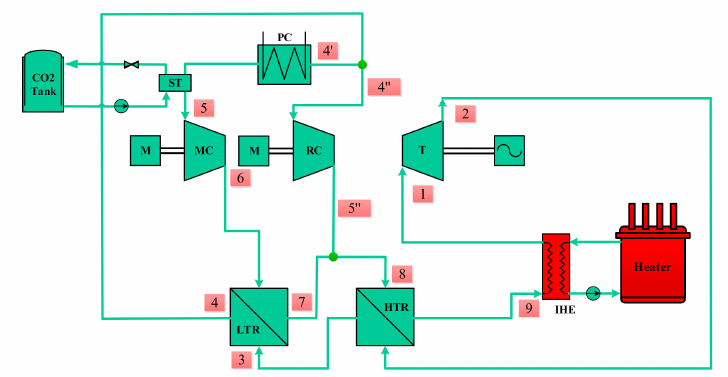
Figure 1. Supercritical carbon dioxide recompression cycle power generation